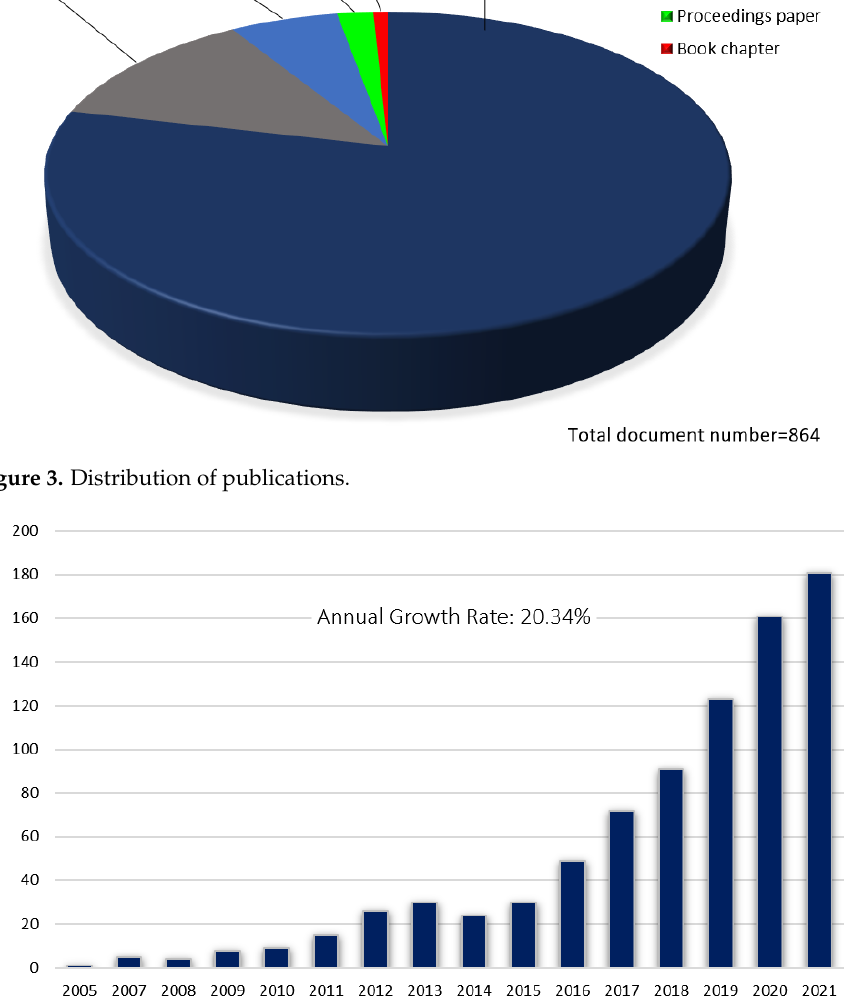
Figure 3. Distribution of publications.